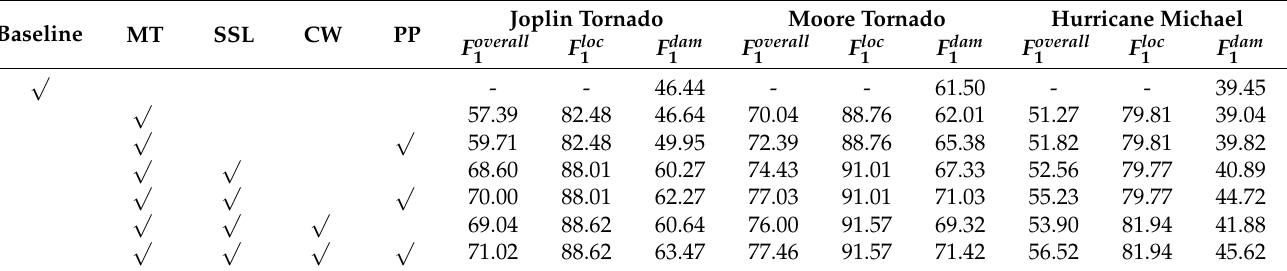
process, and the influence of noisy pseudo-labels is reduced at the same time. (4) PP is a simple but effective strategy to boost the model performance further. Table 6. Ablation experiments for different components of the proposed framework on three datasets (%).